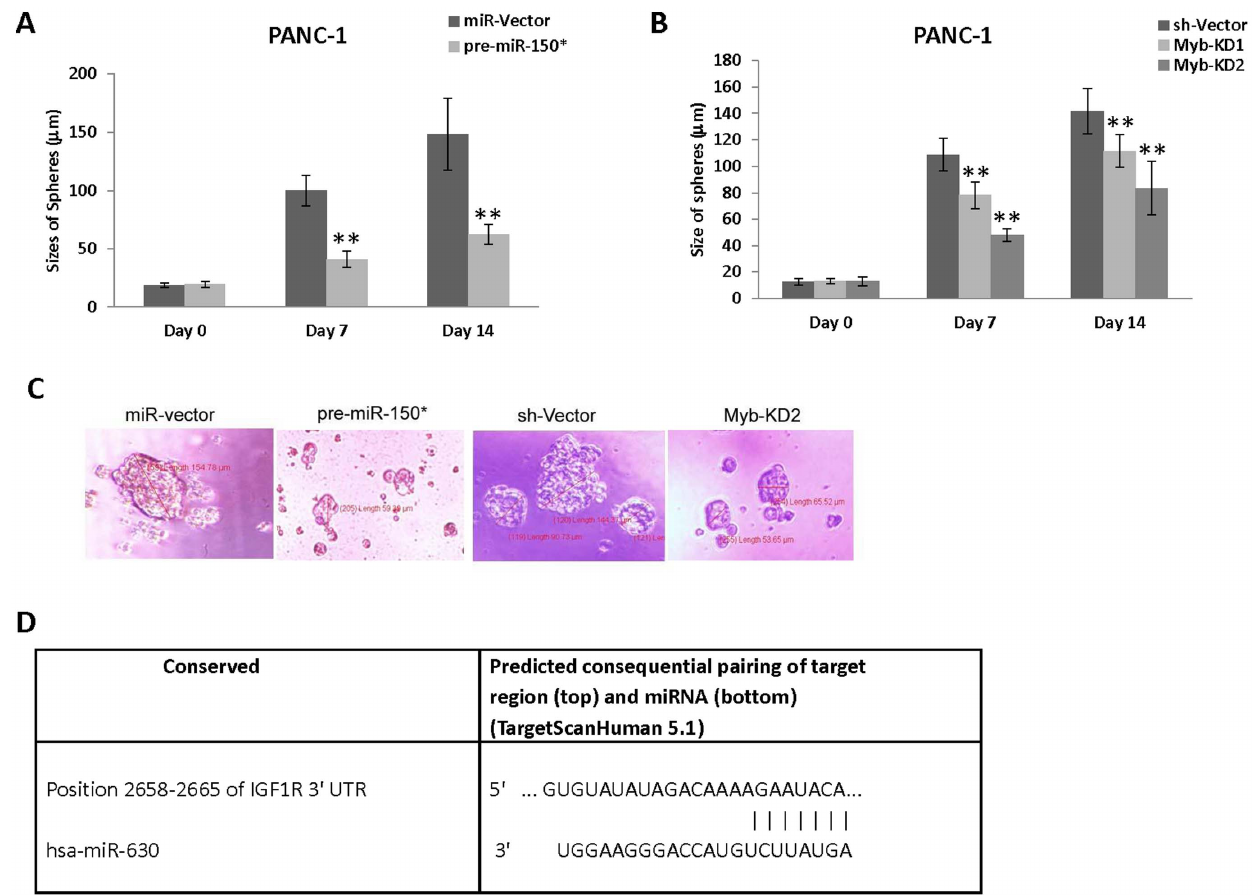
Figure 6. Expression of pre-miR-150* and knockdown of c-Myb inhibited CD44 + /CD24 + stem-cell like spheres formation in cells. (A and C) Pre-miR-150* inhibited sphere formation in CD44 + /CD24 + cells. (B and C) c-Myb knockdown inhibited sphere formation in CD44 + /CD24 + PANC- 1 cells. For sphere formation, the CD44 + /CD24 + cells were sorted by flow cytometry from stably transfected pre-miR150* and sh-Myb knock down cells, respectively. The sizes of spheres were photographed and measured on a 100 m m scale and magnification 400 6 using Olympus fluorescence microscope digital camera software and DP2-BSW software. The error bars represent the mean of 15 sphere determinations 6 the standard deviation. ** was significantly different in comparison to control spheres. Data were analyzed by ANOVA; Tukey HSD test for multiple comparisons. **P , 0.0001 vs control. (D) Scheme showing predicted target conserved site of miR-630 in the 3 9 UTR of IGF-1R.